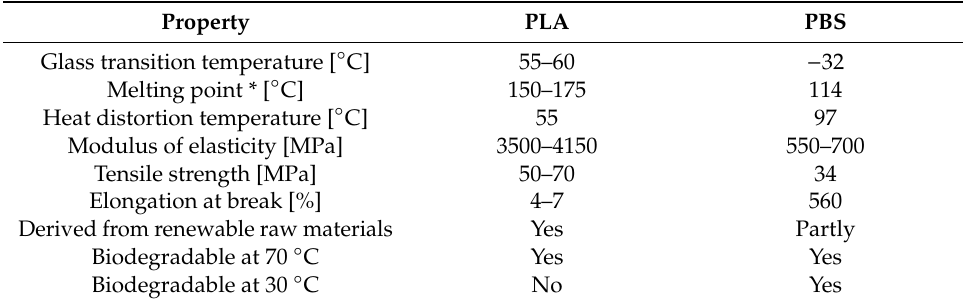
Table 1. Material properties of polylactide (PLA) and PBS, adapted from [19–21]. Property PLA PBS Glass transition temperature [ ◦ C] 55–60 − 32 Melting point * [ ◦ C] 150–175 114 Heat distortion temperature [ ◦ C] 55 97 Modulus of elasticity [MPa] 3500–4150 550–700 Tensile strength [MPa] 50–70 34 Elongation at break [%] 4–7 560 Derived from renewable raw materials Yes Partly Biodegradable at 70 ◦ C Yes Yes Biodegradable at 30 ◦